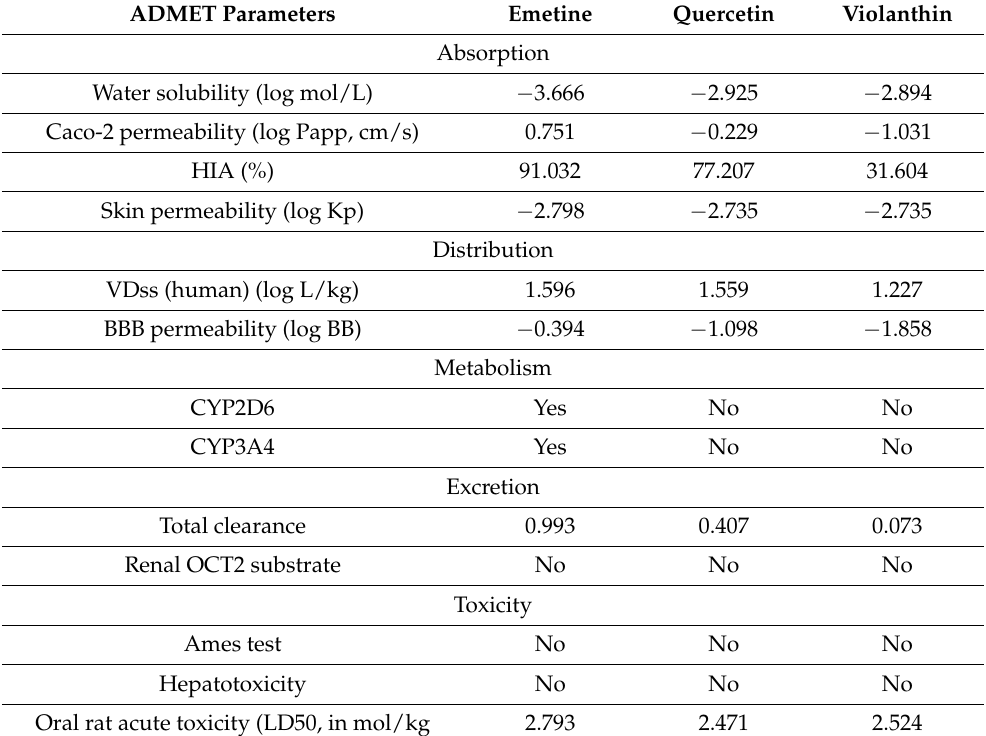
Table 5. The pharmacokinetic profile and toxicity prediction of Viola canescens compounds through pkCSM